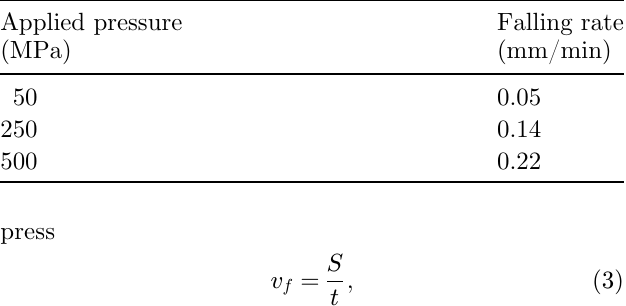
Table 1. The fall rates ( v Applied pressure